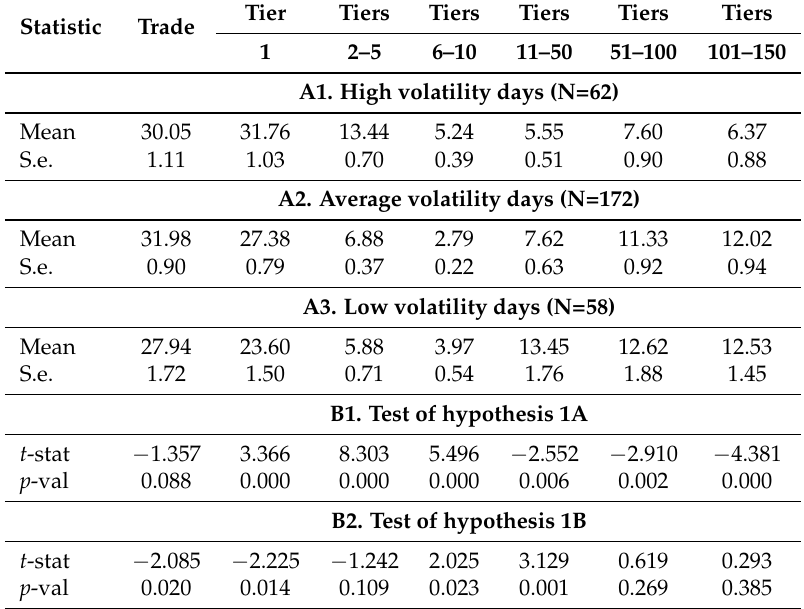
Table 3. This table reports the information shares of trade and limit order prices. The price vector consists of last trade price, and depth-weighted prices of limit orders at tier 1, tiers 2–5, tiers 6–10, tiers 11–50, tiers 51–100, and tiers 101–150 on both sides of the market. Their dynamics at the one-minute frequency are modeled with a vector error correction model with 10 lags, and information shares are computed from the Cholesky decomposition of the covariance matrix of the residuals. The model is estimated separately for each day. Each day is defined to be from 0:00:00 to 23:59:59 ET. Data are from BTC-e for the period from December 7, 2013 to September 24, 2014. Panels A1, A2, and A3 report the means and standard errors of information shares separately for the high volatility, average volatility, and low volatility sub-samples partitioned as described in the text. Panel B1 reports the test statistics of the difference in mean information share of each order category on high-volatility days versus average-volatility days. Panel B2 reports the test statistics of the difference in mean information share of each order category on low-volatility days versus average-volatility days. Tier Tiers Tiers Tiers Tiers Statistic Trade